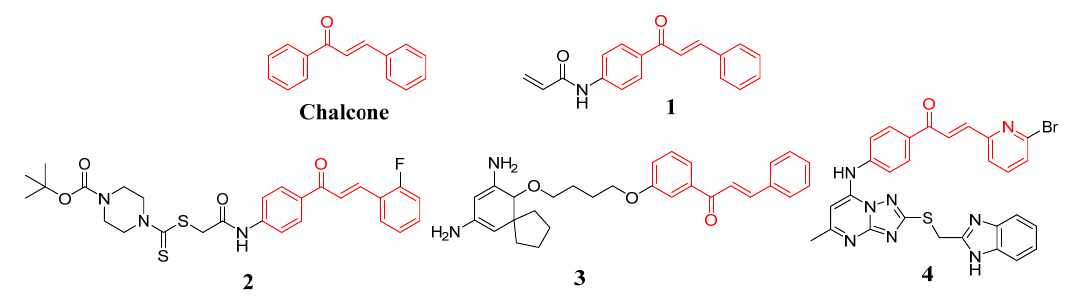
Figure 1. Structures of chalcone derivatives as anticancer agents previously reported.